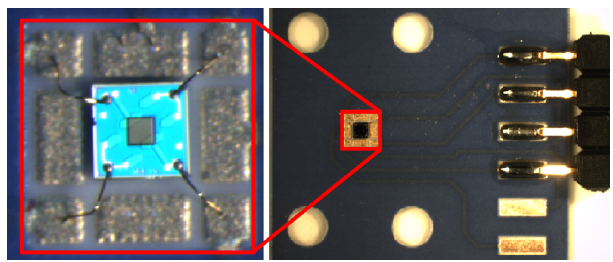
Figure 6. Humidity sensor chip is wire bonded onto a ceramic sub- strate. To avoid external mechanical stress, the sensor is not glued to the substrate. Mechanical stress would influence the measurement results.